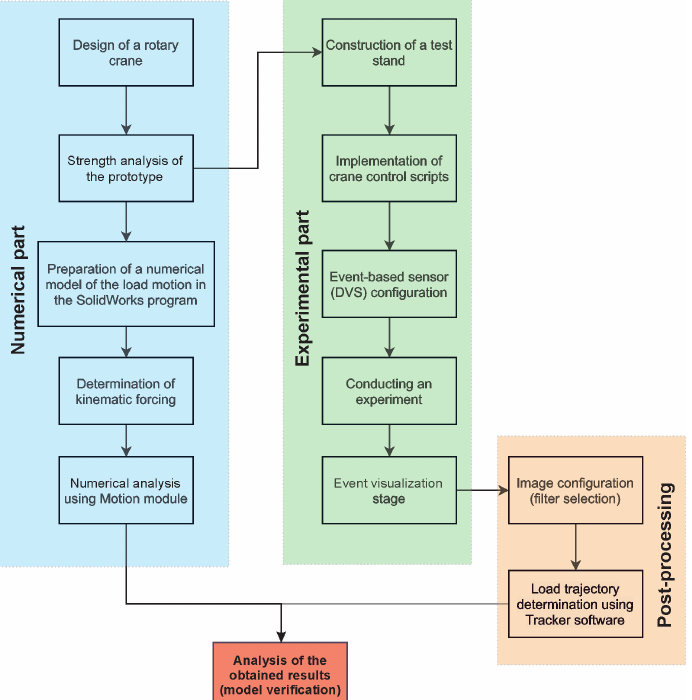
Figure 1. Flowchart of the completed tasks divided into numerical and experimental part, post- processing and results